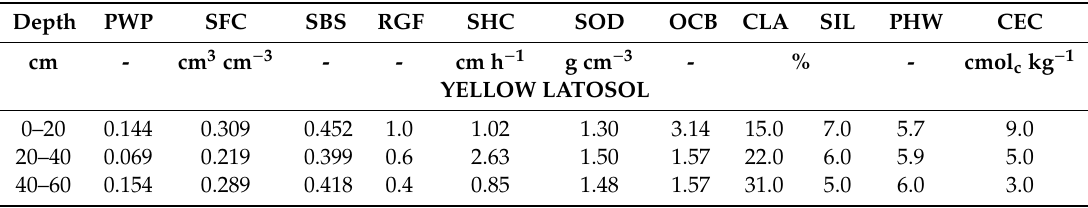
Table 1. Properties of the yellow latosol used for calibration of the Decision Support System